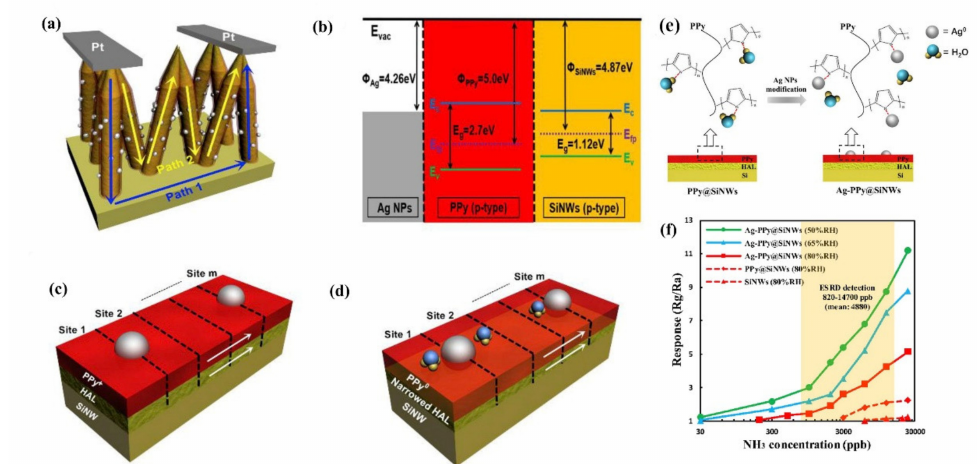
Figure 34. Schematic illustrations showing the NH 3 -sensing mechanism of